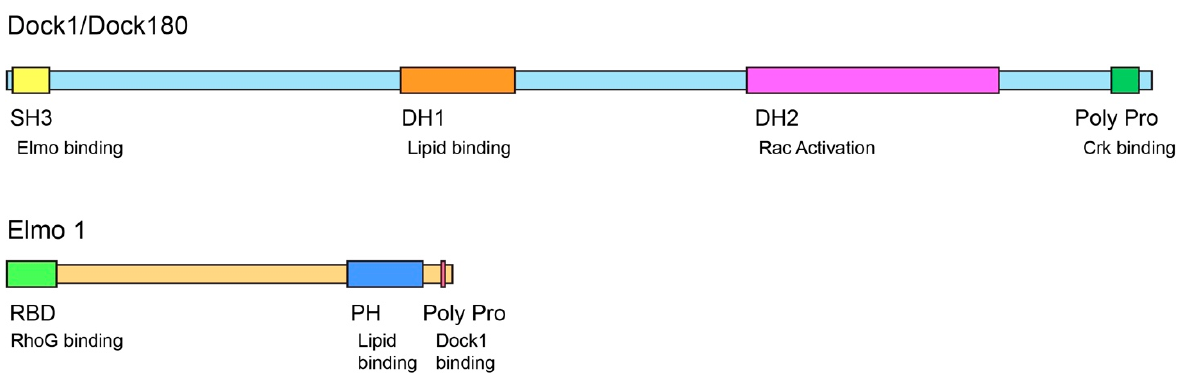
Figure 1. Domain Structure of Dock1/Dock180 and Elmo1. Dock180 is characterized by the evolutionarily conserved DH-1 domain that mediates PIP3 binding and the DH-2 domain that encompasses Rac GEF activity. The N-terminal SH3 domain mediates binding with the C-terminal poly pro domain of Elmo.